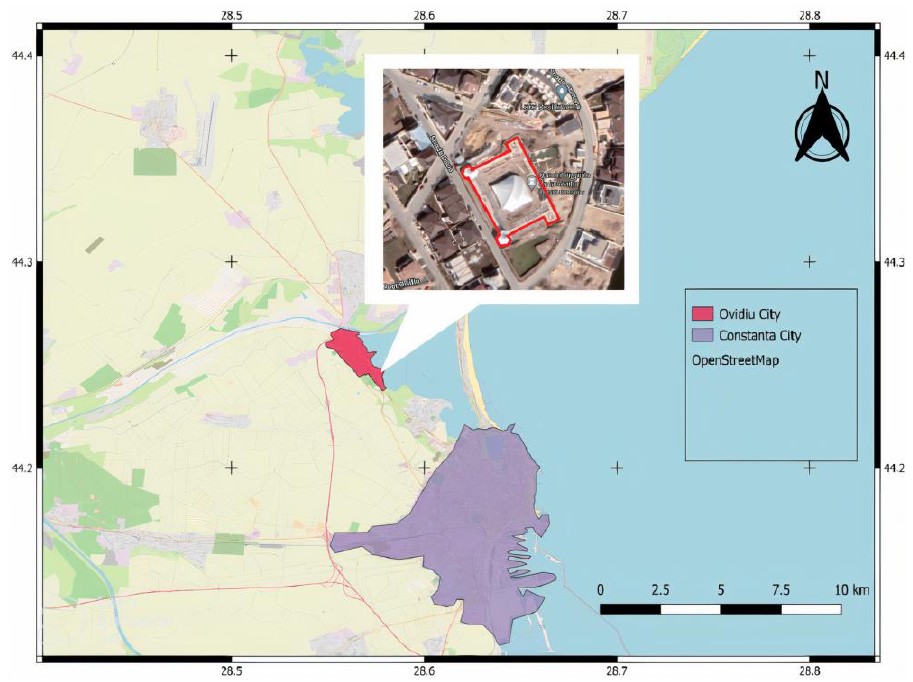
Figure 1. Location of the archaeological site. The layout of the fortress is rectangular (Figure 2), with the longest side running NNV-SSE. The interior is around 2200 square meters. The two rectangular towers to the east are unique among fortifications of their sort since only two of their sides project outside the enclosure, with the eastern side running parallel to the curtain